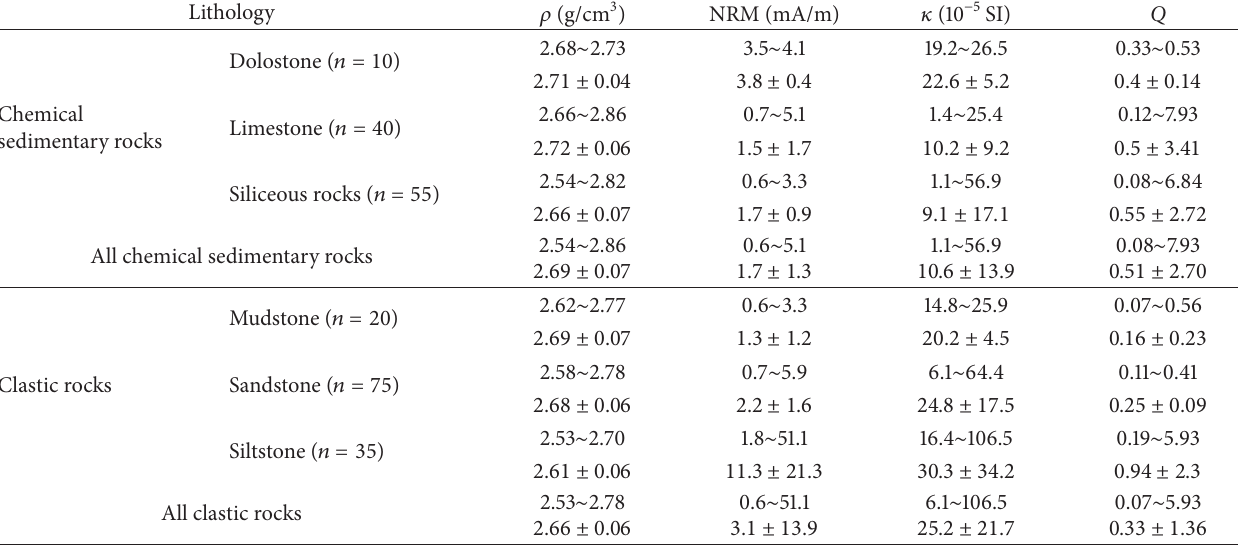
Table 1: Statistical results of density ( 𝜌 ), magnetic susceptibility ( 𝜅 ), natural remanent magnetization (NRM), and K¨oenigsberger ratio ( Q ) of different sedimentary rocks from the Suhbaatar-Ulaanbaatar-Dalandzadgad profile in Mongolia.